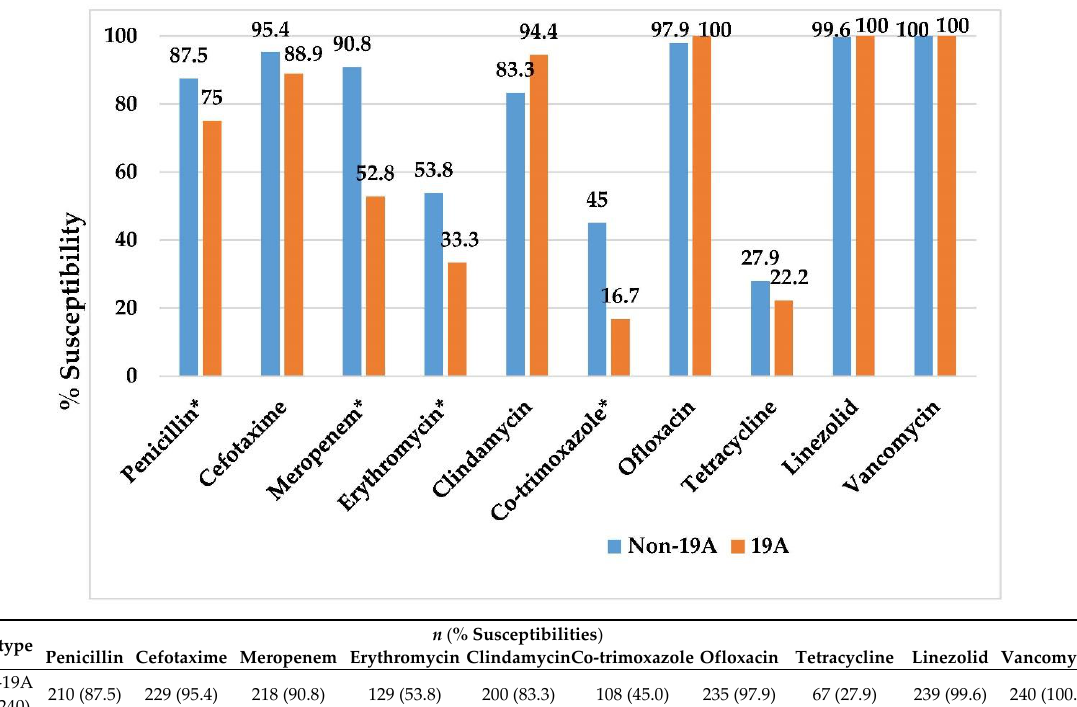
erythromycin, respectively. cin, respectively.